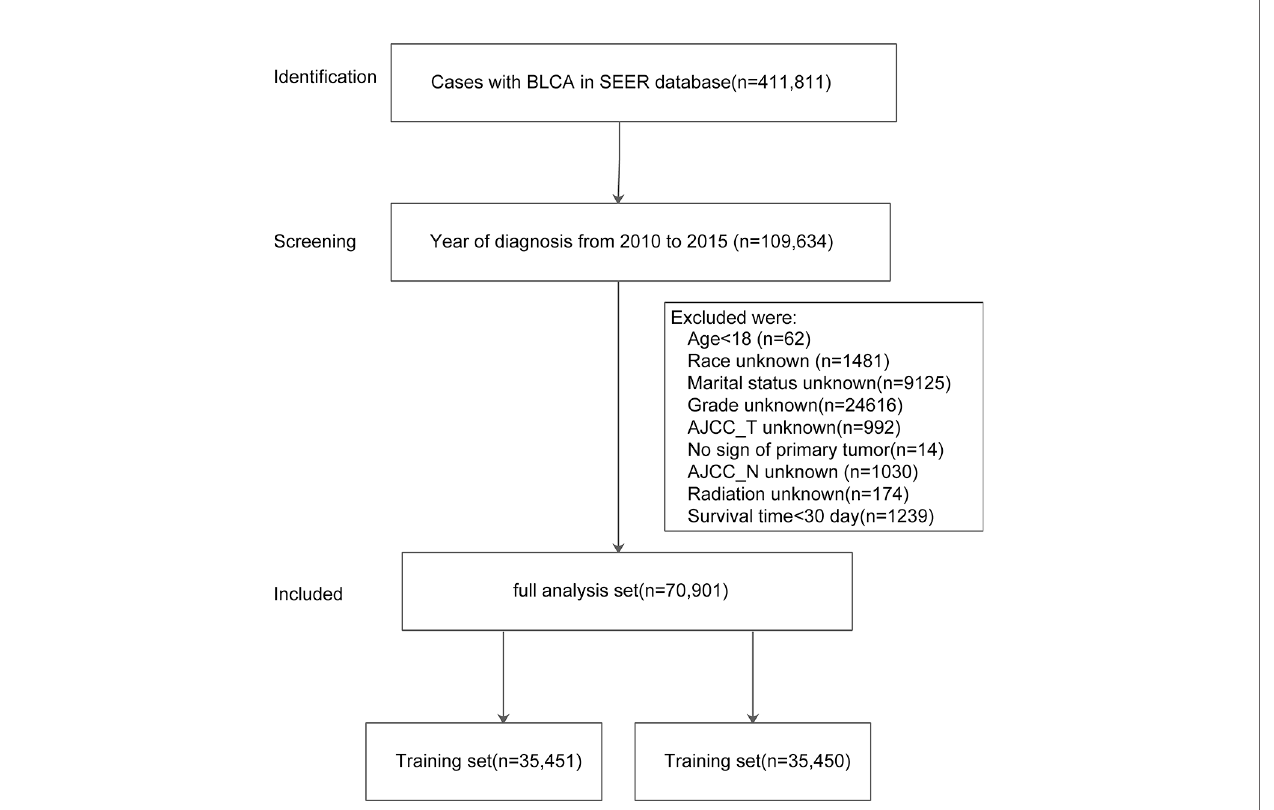
FIGURE 1 | Flowchart of patient selection and dataset formulation. Of 411,811 BLCA cases in SEER, 109,634 cases diagnosed from 2010 – 2015 were screened with 70,901 included in the